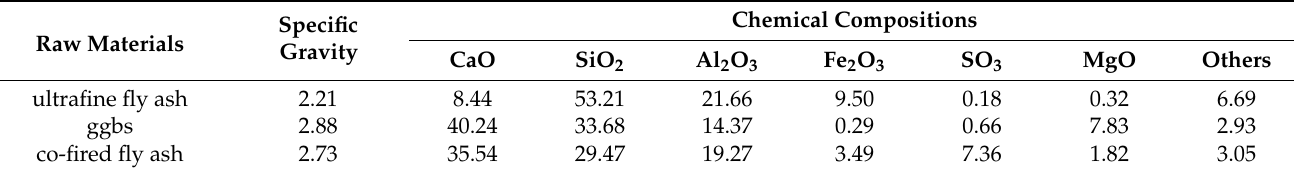
Table 1. The specific gravity and chemical compositions of the three raw materials.